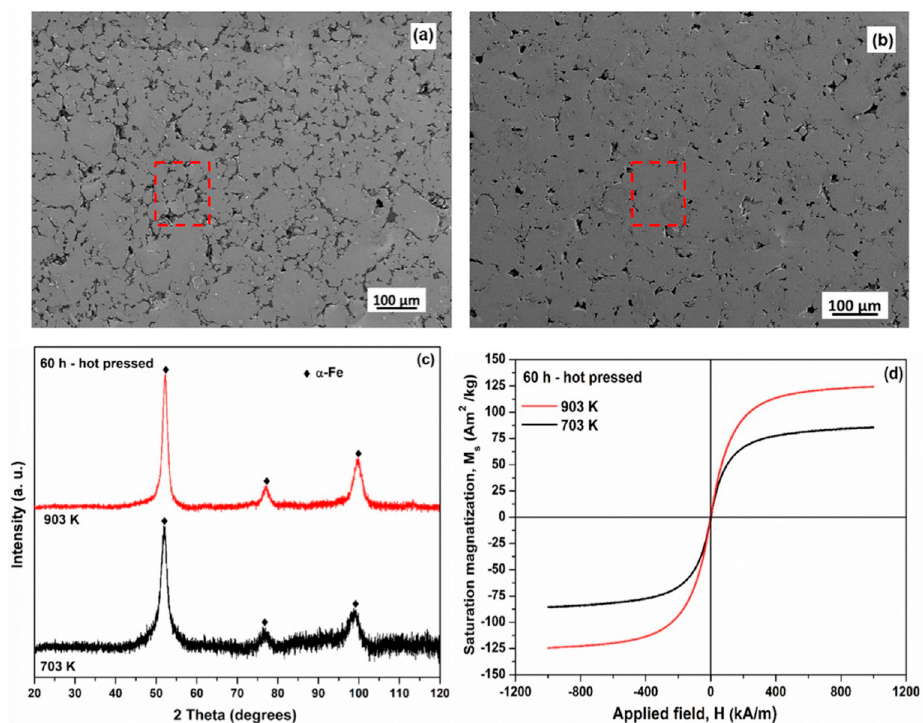
Figure 14. SEM micrographs of the 60 − h milled Fe80Nb10B10 metallic glass hot − pressed at ( a ) 703 K with 880 MPa and ( b ) 903 K with 640 MPa. The red mark is the crack on the surface of the material after hot pressing. ( c ) XRD patterns of the 60 h milled samples after hot pressing at 723 K and 903 K. α− Fe is stable at temperatures of 703 K and 903 K. ( d ) Hysteresis loops for the 60 h milled samples hot-pressed at 723 K and 903 K. The saturation magnetization of the samples hot pressed at 703 and 903 K are 90 and 125 Am 2 /kg, respectively, reprinted with permission from Ref. [106] 2017, Elsevier.